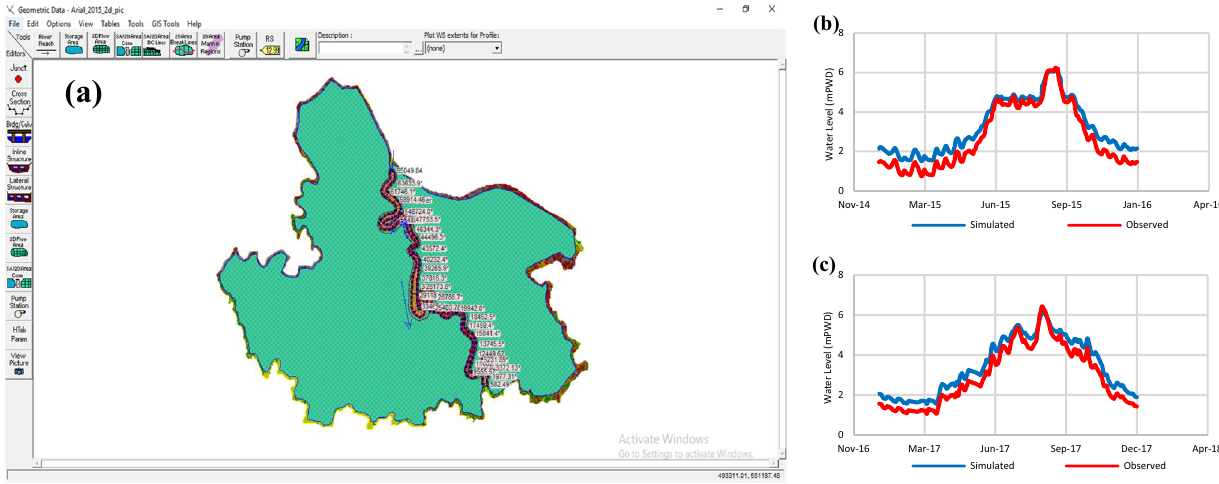
Fig. 5 HEC-RAS 1D-2D coupled a Model set up b Calibration and c Validation of the Arial Khan 1D model at Chowdhury Char (SW